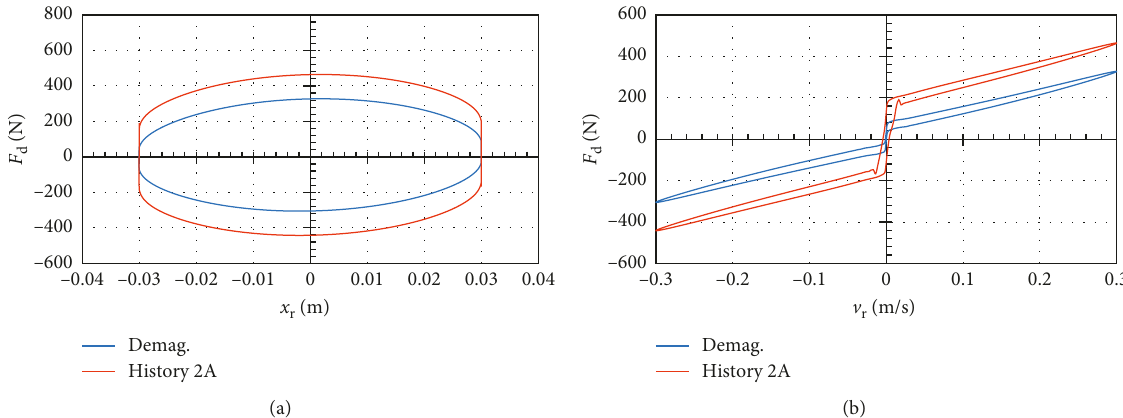
Figure 18: Off-state force: demagnetized (blue) and following 2A current excitation, no demagnetization (red). (a) F